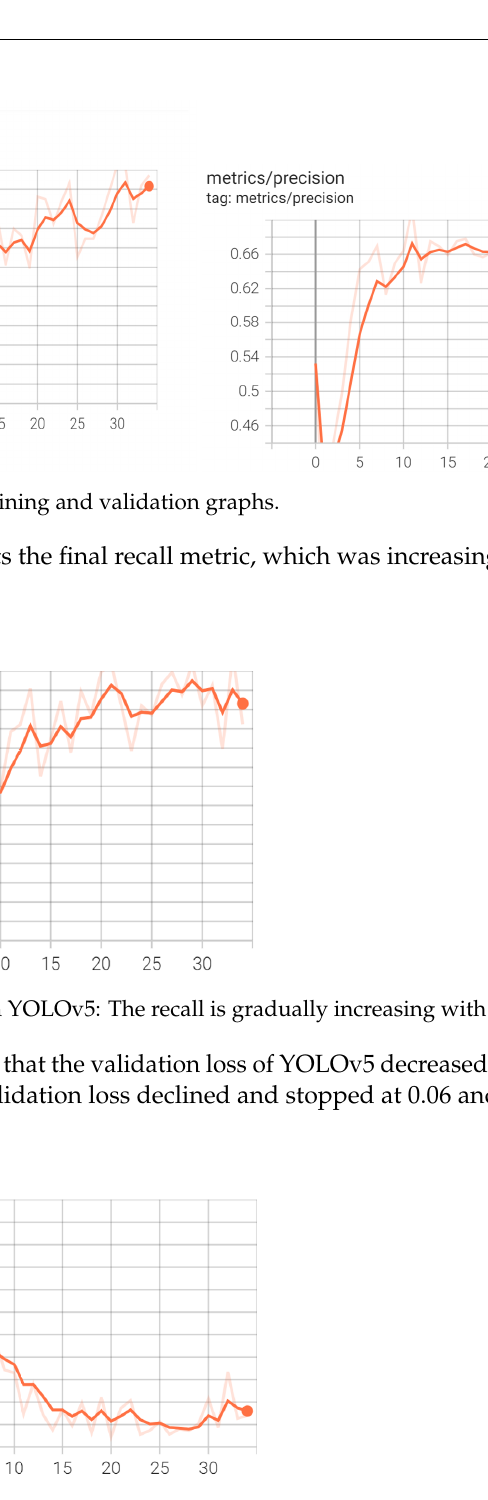
Figure 25. Validation loss graph YOLOv5: Validation loss was decreasing gradually, indicating the model prediction was